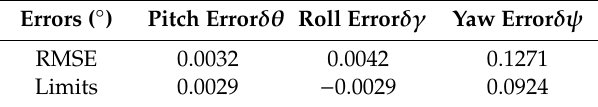
Figure 4. Statistical curves of alignment errors. ( a ) The error of pitch angle; ( b ) the error of roll angle; ( c ) the error of heading angle. Table 2. Statistical properties of alignment